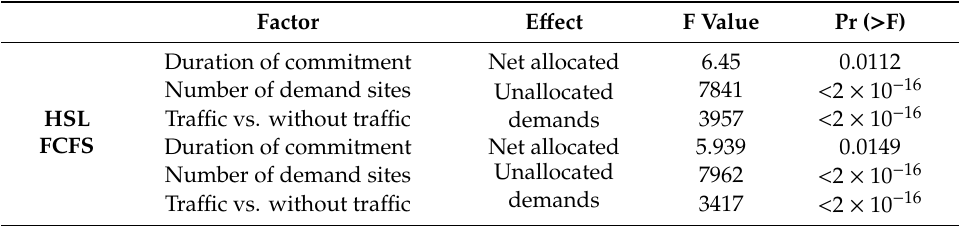
Figure 6. RA in the geographic information system (GIS) Space NetLogo implementation. Table 4. ANOVA test